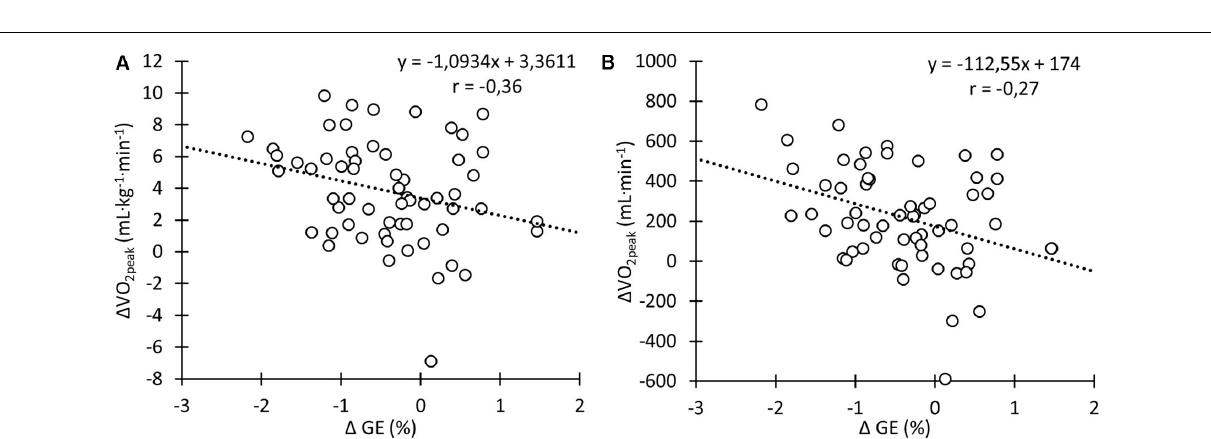
FIGURE 6 | Correlation between changes in ˙ V O 2peak relative to body mass (A) and absolute ˙ V O 2peak (B) and changes in gross efficiency (GE) during the training intervention.